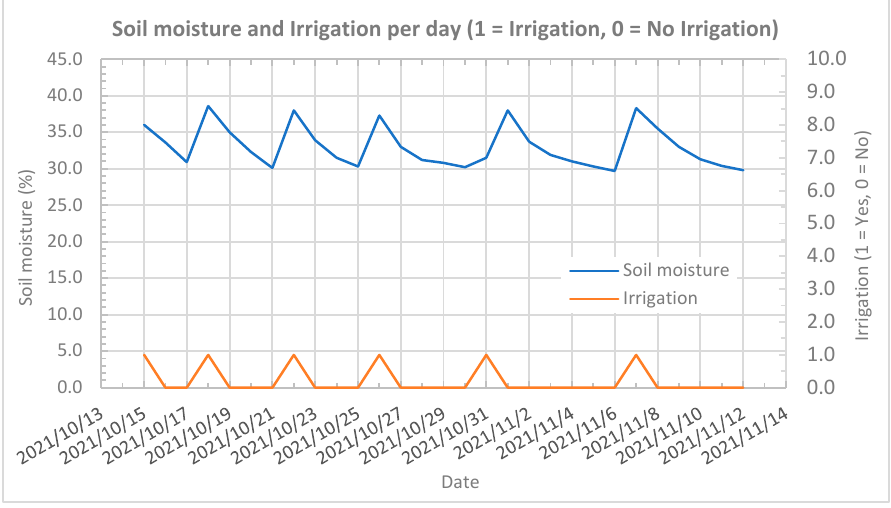
Figure 22. Automated irrigation using the IoT node.